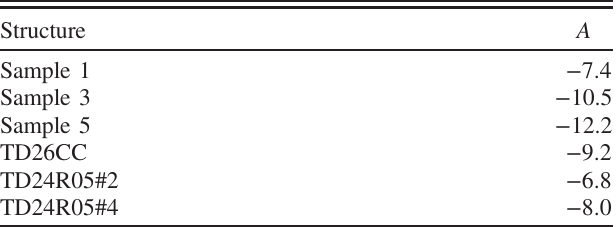
rate as a function of the cumulative number of pulses, in our dc conditioning experiment and in comparable rf conditioning experiments